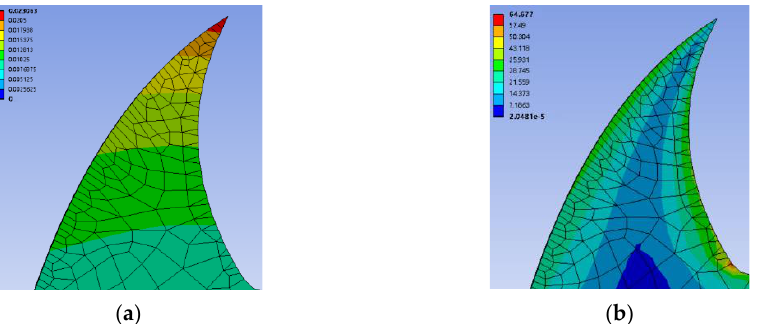
Figure 9. Analysis results. (a) Serrated disc tooth strain model; (b) Serrated disc tooth stress model.